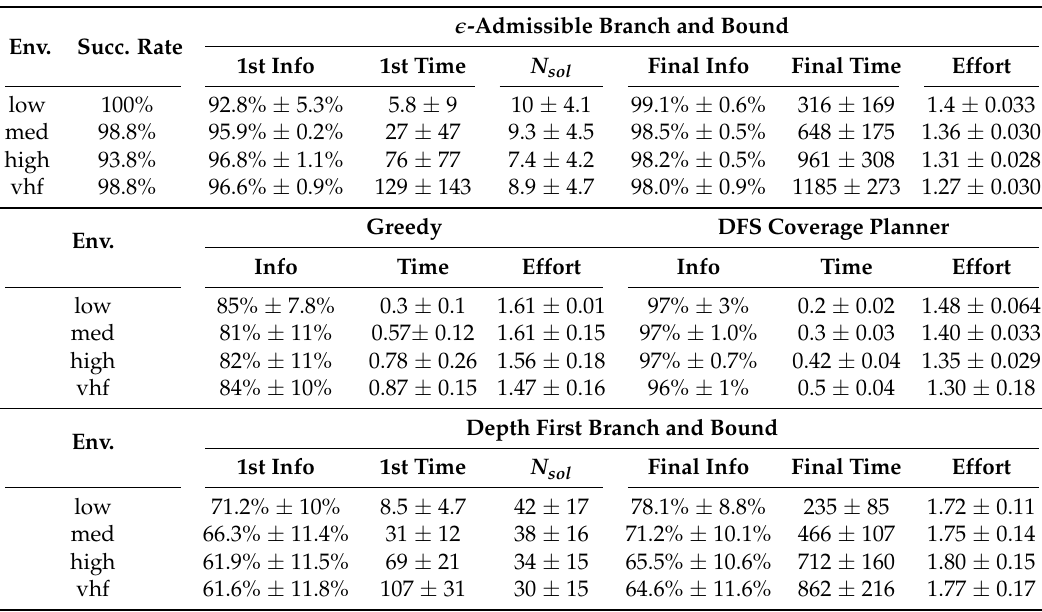
Table 2. Experiment 3 results for uniform environments, mean of 80 trials.